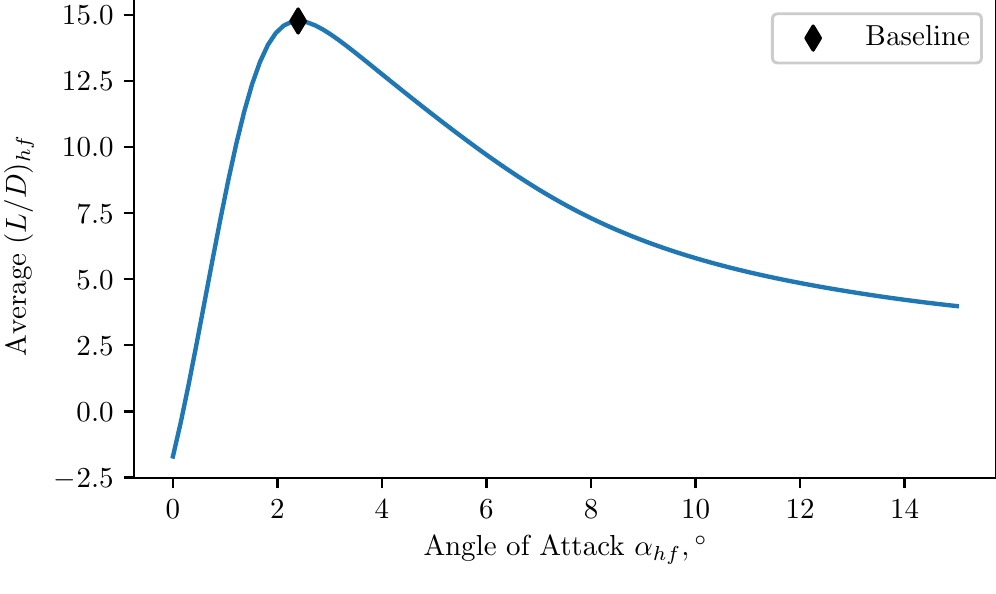
Figure 14. Average ( L / D ) hf Ratios for the Waid-Lindberg supercavitating